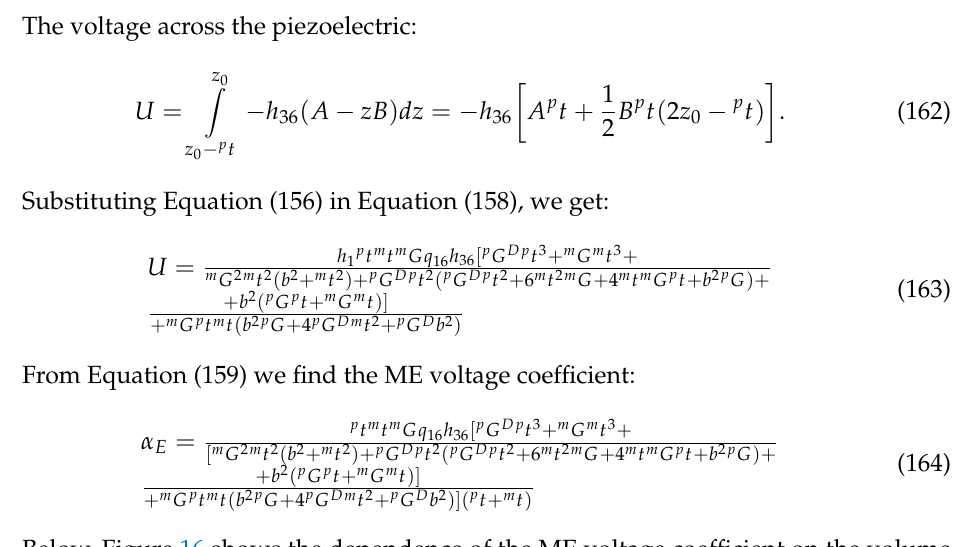
Figure 17. Asymmetric magnetoelectric composite with bimorth LiNbO 3 layer at torsional vibra- tions.